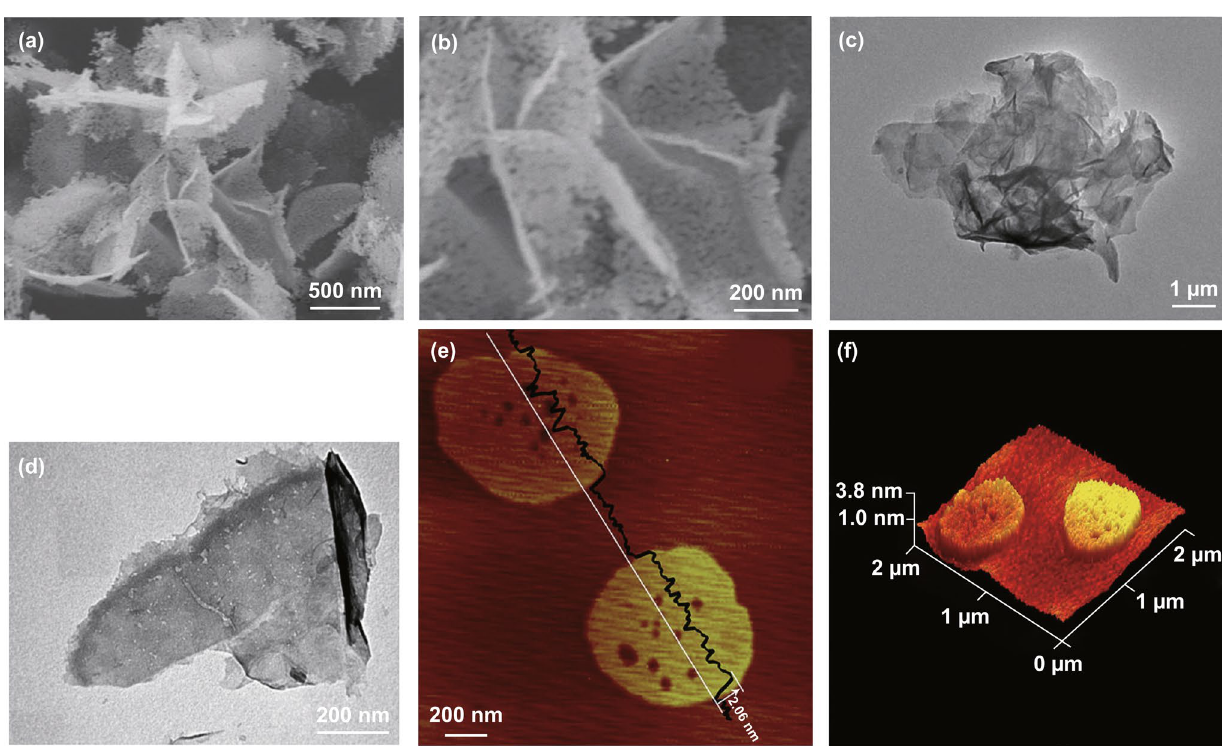
Fig. 3 a , b SEM and c , d TEM images of Zn–Co‑LDH nanosheets. e Height profile and f the 3D PF‑AFM images of Zn–Co‑LDH nanosheets prepared by microwave irradiation. Reproduced with permission from Ref. [33]. Copyright 2015 The Royal Society of